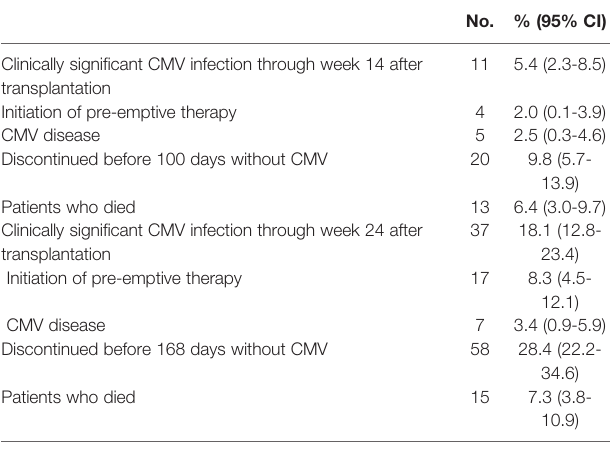
TABLE 2 | Cumulative incidence of CMV infection and discontinuation at 100 days and at 168 days in 204